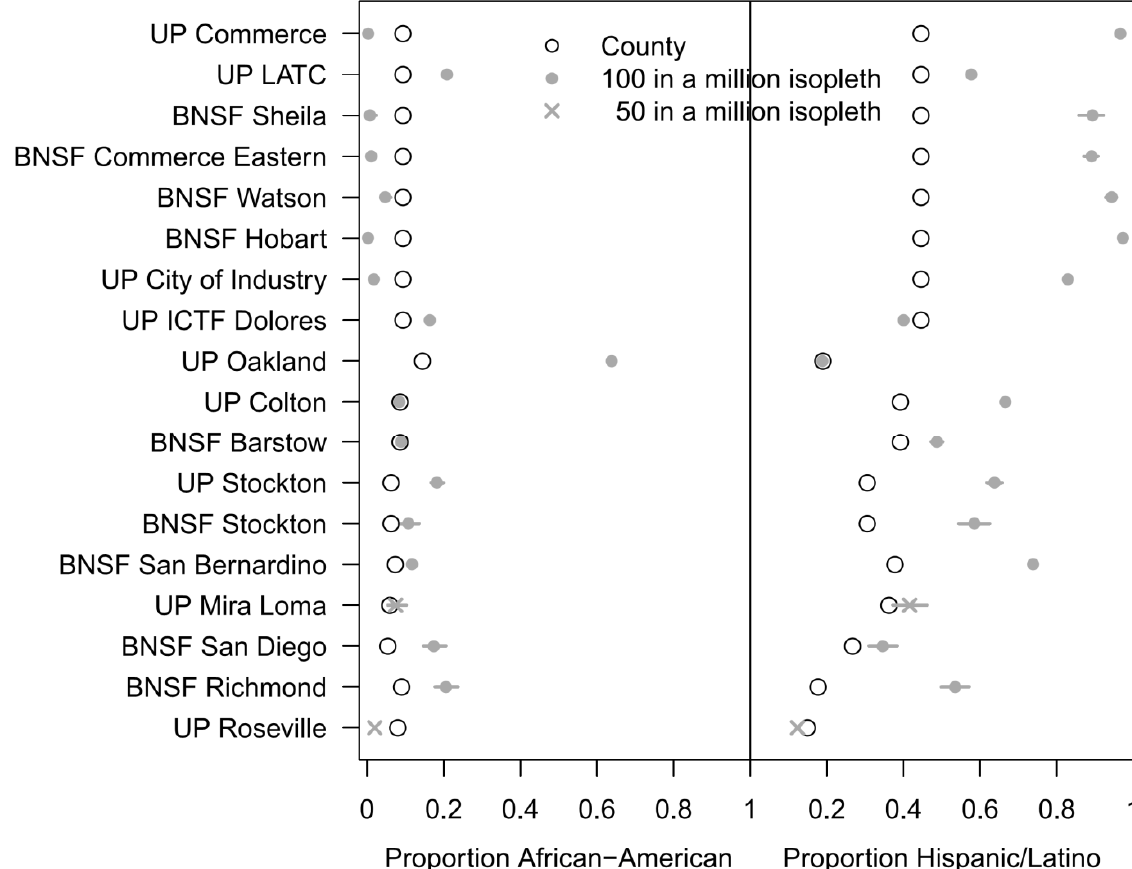
respectively). See Table S1 for County population percentages non-white and Table S2 for